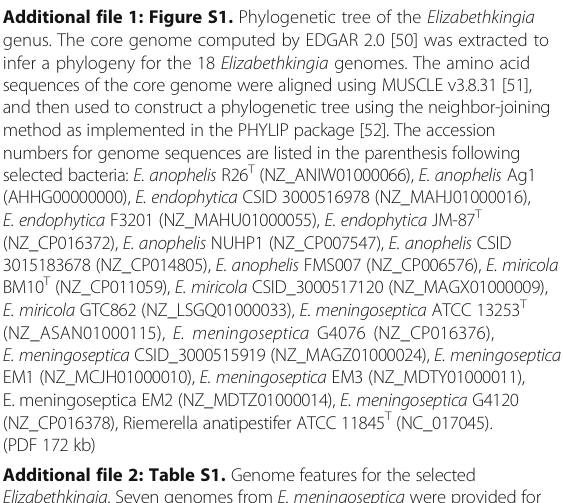
Additional file 1: Figure S1. Phylogenetic tree of the Elizabethkingia genus. The core genome computed by EDGAR 2.0 [50] was extracted to infer a phylogeny for the 18 Elizabethkingia genomes. The amino acid sequences of the core genome were aligned using MUSCLE v3.8.31 [51], and then used to construct a phylogenetic tree using the neighbor-joining method as implemented in the PHYLIP package [52]. The accession numbers for genome sequences are listed in the parenthesis following selected bacteria: E. anophelis R26 T (NZ_ANIW01000066), E. anophelis Ag1